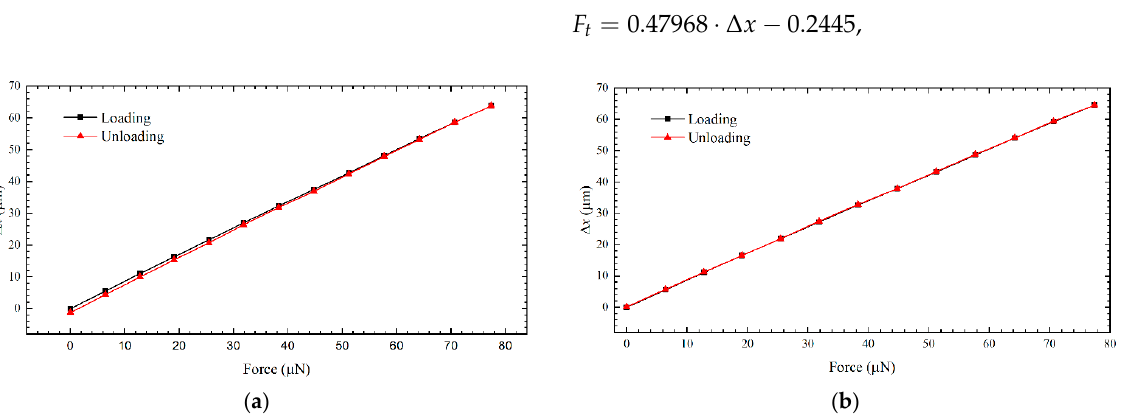
Figure 14. The electrostatic force-displacement relationship in loading and unloading process: ( a ) before drift compensation, ( b ) after drift compensation.